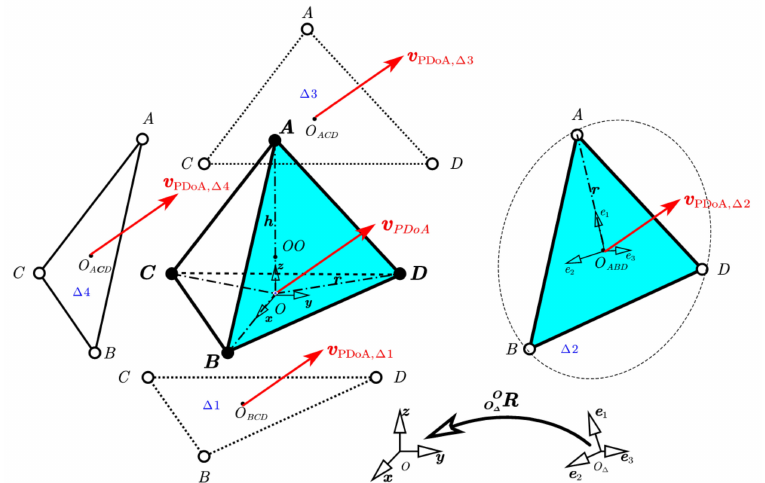
Figure 2. Tetrahedral decomposition and spatial